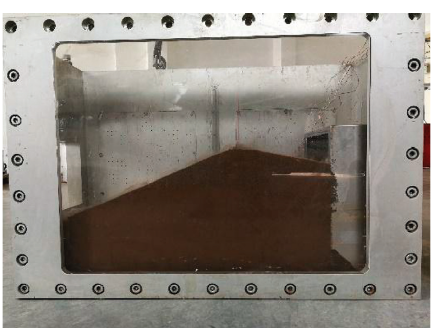
Figure 3: Tailings dam